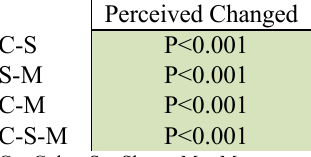
Table 2: Results of the ANOVA calculated to examine H0: “There is no significant difference in ratio of perceived changes between the different types of changes.” (P≥0.05 is considered significant)